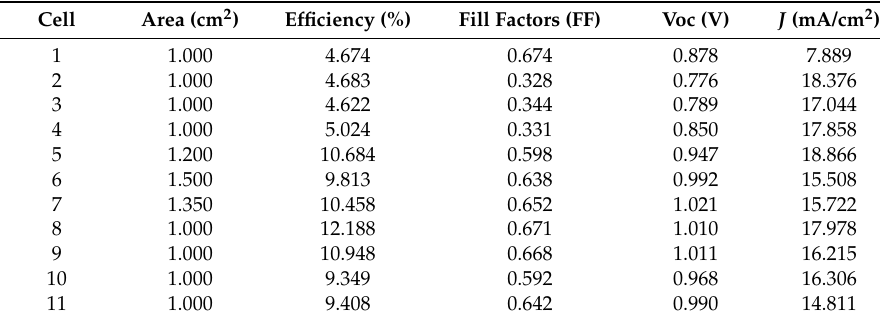
Figure 1. I - V curve of perovskite solar cells. Figure 1. I-V curve of perovskite solar cells. Table 1. Electrical performance of perovskite solar Table 1. Electrical performance of perovskite solar cells.